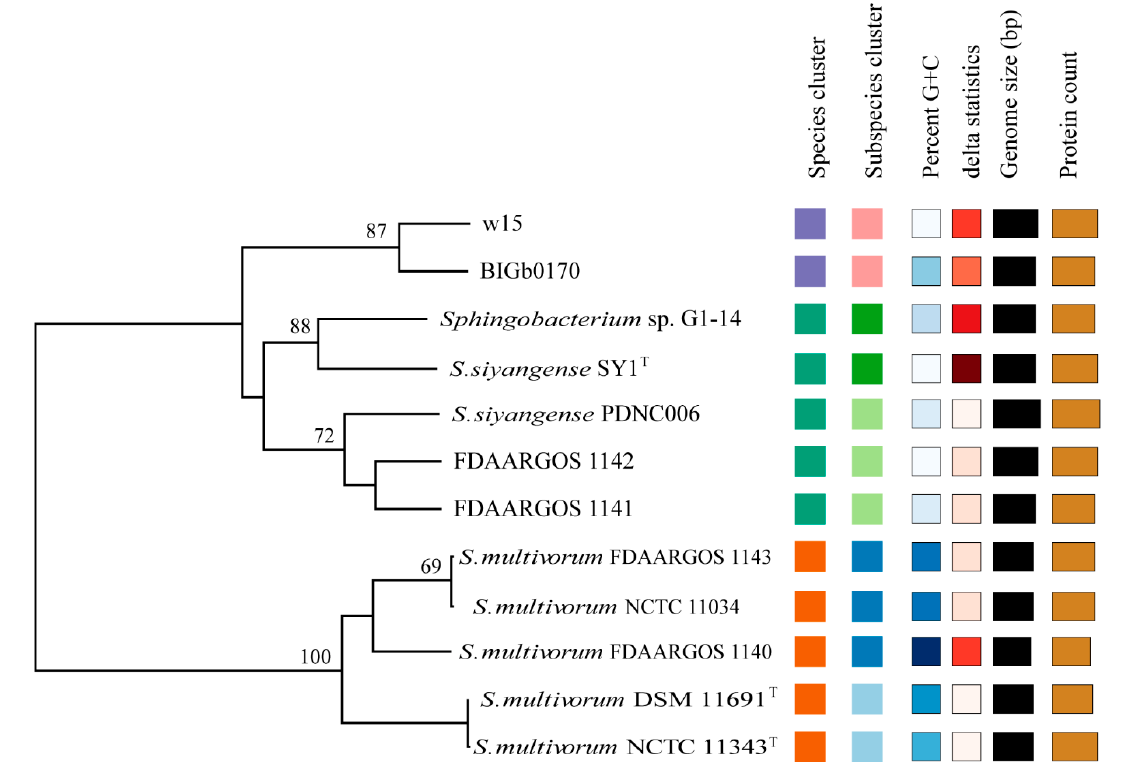
Figure 5. Tree inferred with FastME 2.1.6.1 [36] from GBDP distances calculated from the genome sequences. The branch lengths are scaled in terms of GBDP distance formula d5. The numbers above the branches are GBDP pseudo-bootstrap support values > 60% from 100 replications, with an average branch support of 65.2%. The tree was rooted at the midpoint [37]. Colored squares indicate relatedness (same color, same parameter value class, on the basis of standard FastME settings).